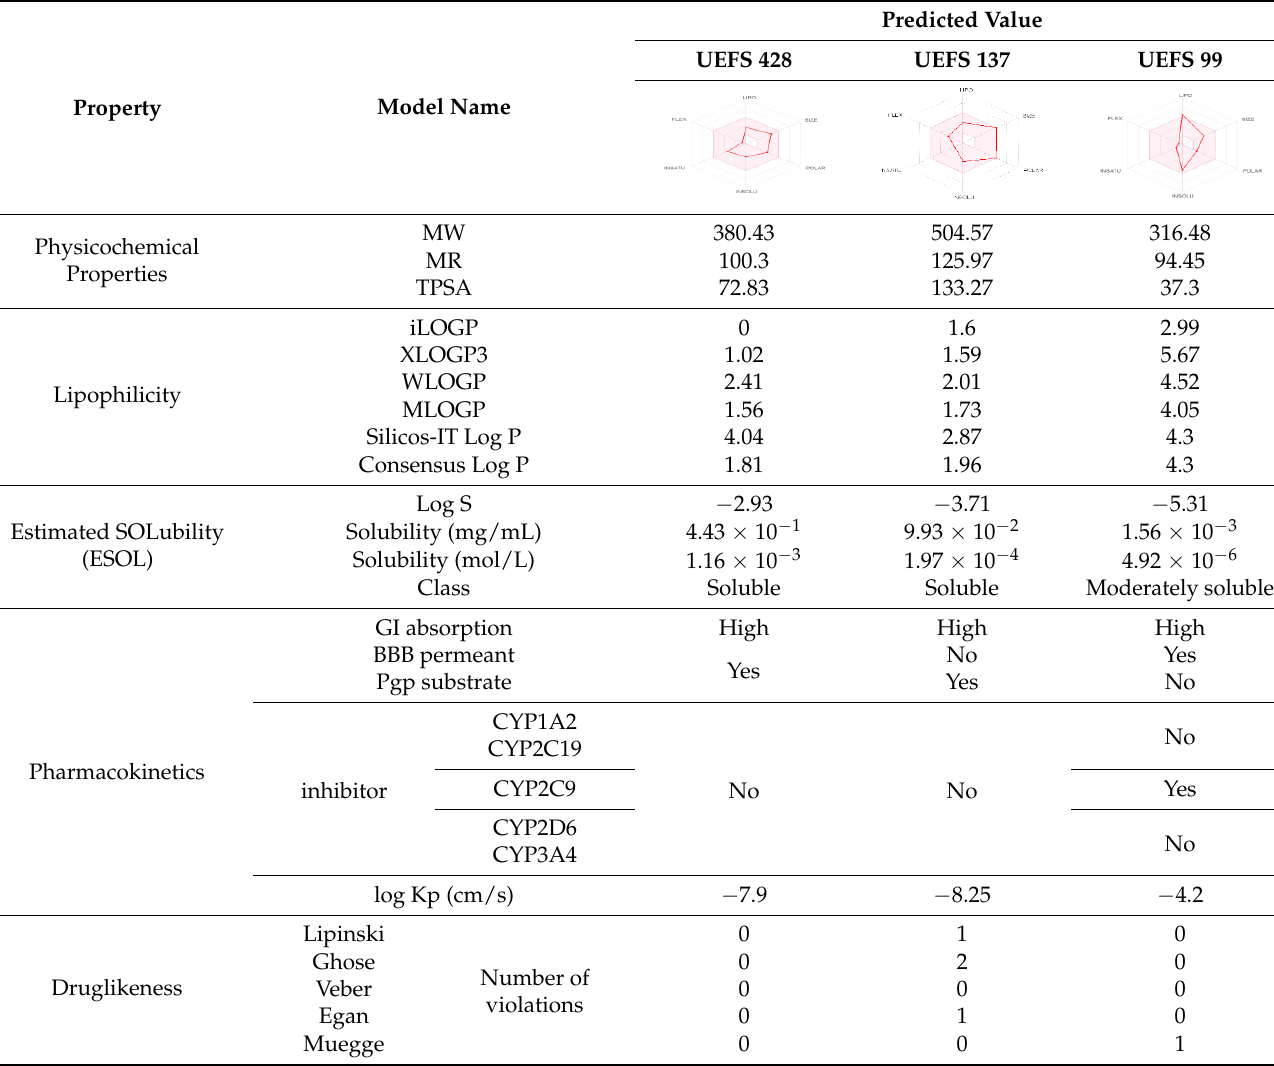
Table 2. Physicochemical and druglikenes properties of top 3 compounds.